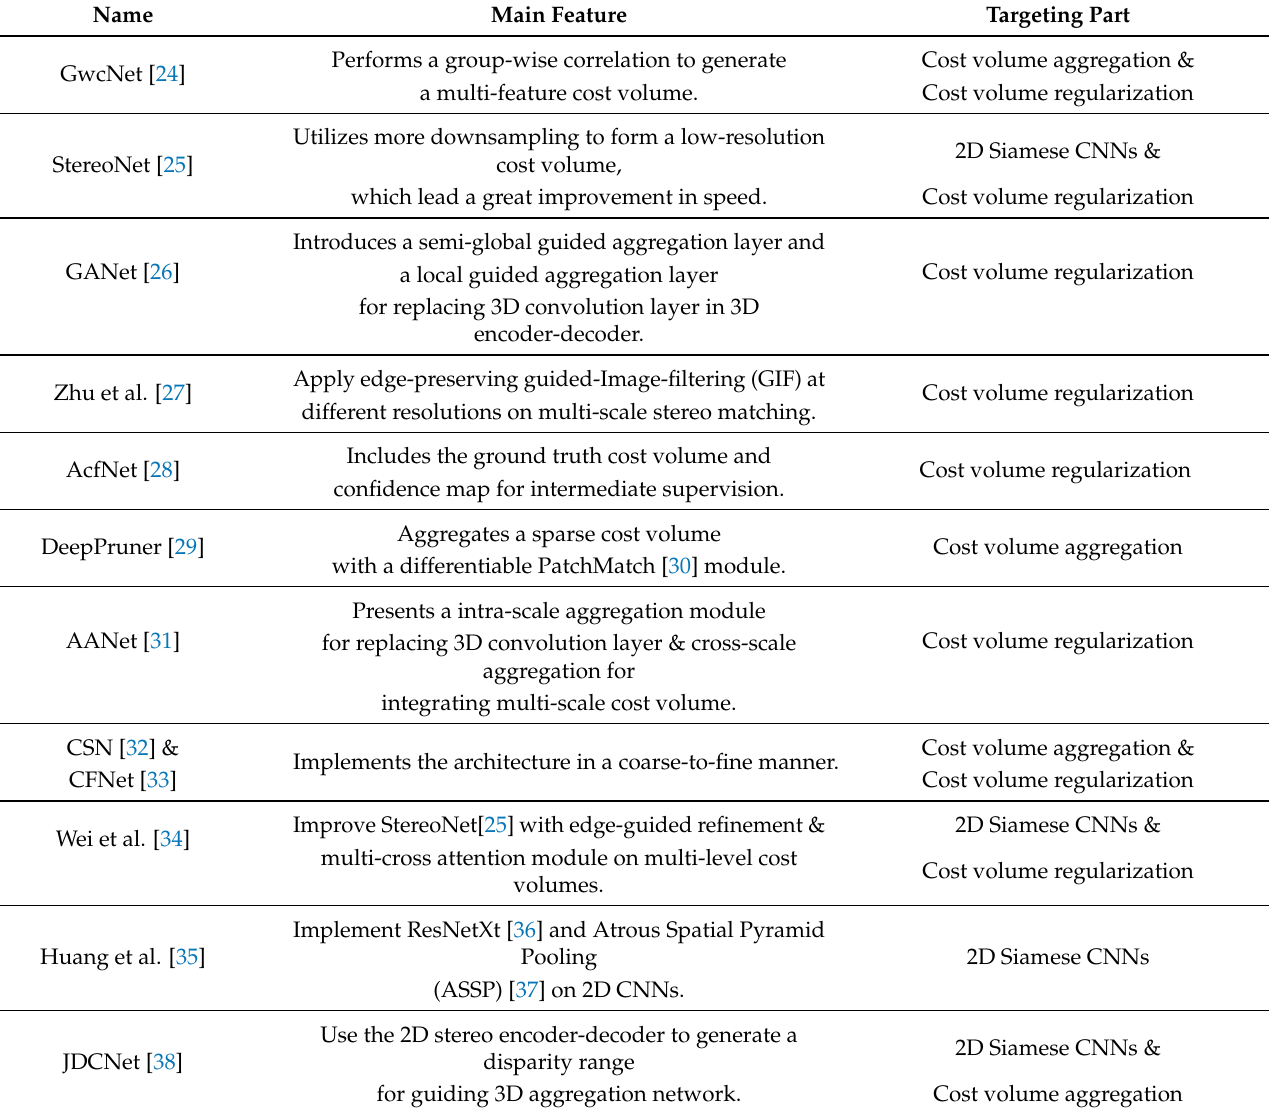
Table 1. Recent studies on stereo matching. We clarify where their modifications target stereo matching